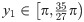
The boundary curve of the posterior leaflet.The value ranges of variables of P1 are y1∈[π,3527π) and y2 ∈ [0, sin 3(y1 − π)). The value ranges of variables of P2 are y1∈[3527π,9354π) and y2∈[1114sinπ9,1114sinπ9+(1-1114sinπ9)sin[5423(y1-3527π)])). The value ranges of variables of P3 are y1∈[9354π,2π] and y2∈[0,sin165(2π-y1)).